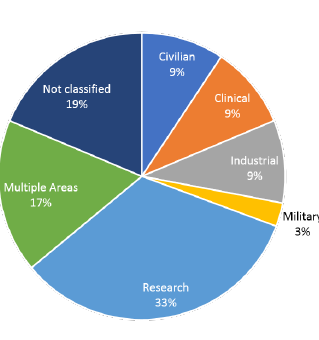
Figure 10. This chart portrays the classification of the exoskeletons by the field(s) of